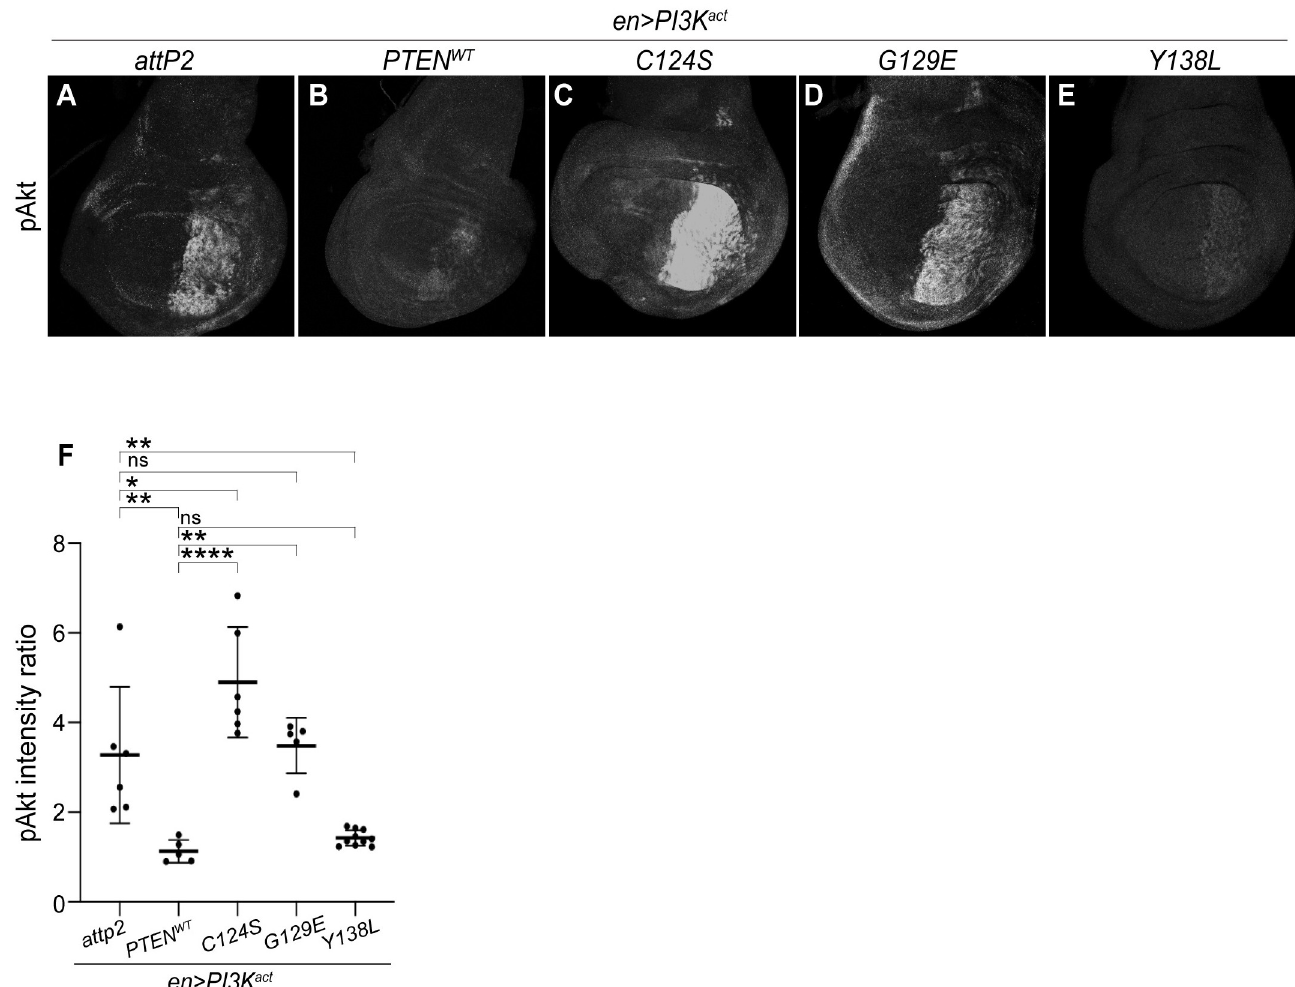
Fig 4. Human PTEN suppresses PI3K-induced Akt signaling. The posterior wing-restricted en-GAL4 driver expressed UAS-PI3K act and UAS-PTEN and variants in the posterior half imaginal wing disc exclusively. Representative images of wing imaginal discs of 3 rd instar female larvae stained with anti-pAkt ( A-E ) for genotypes shown. ( F ) Graph showing pAkt posterior/anterior intensity ratio in the wing discs of each genotype. Expression of PTEN-WT and Y138L but not C124S and G129E restored pAkt levels. Each datum point within scatter plots represents a single wing imaginal disc. Data are expressed as mean ± SD and analyzed using one-way ANOVA with post-hoc Tukey HSD; p > 0.05, � p < 0.05, �� p < 0.01, ���� p < 0.000.1. ns = not significant. Scale bar is 20 μ